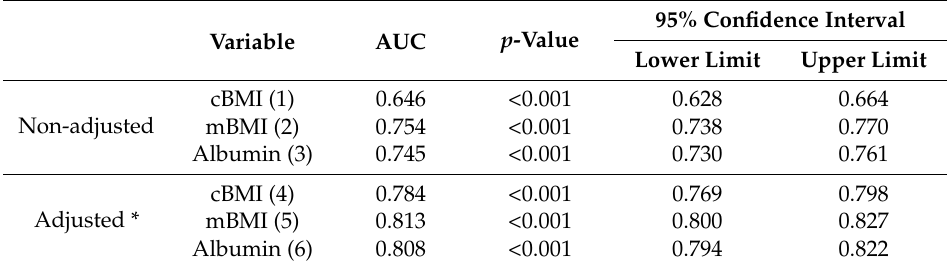
Figure 2. Covariate-adjusted ROC curves showing the risk of 1-year mortality according to cBMI, mBMI, and albumin values. ROC: receiver operating characteristic, cBMI: conventional BMI, mBMI: modified BMI. Table 4. Covariate-adjusted ROC analysis for 1-year